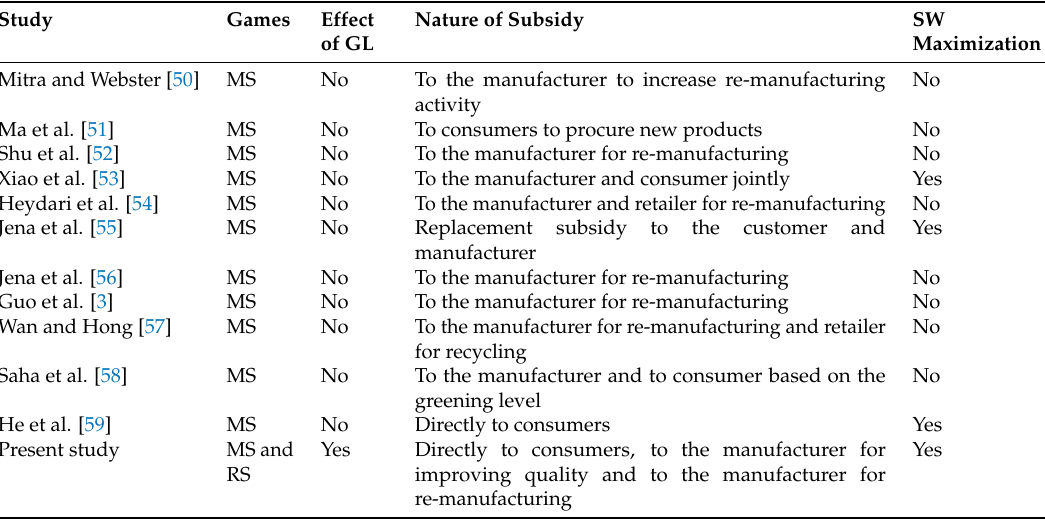
Table 1. Comparison of existing studies with the present study. SW = social welfare; GL = greening level; MS = manufacturer-Stackelberg; RS =